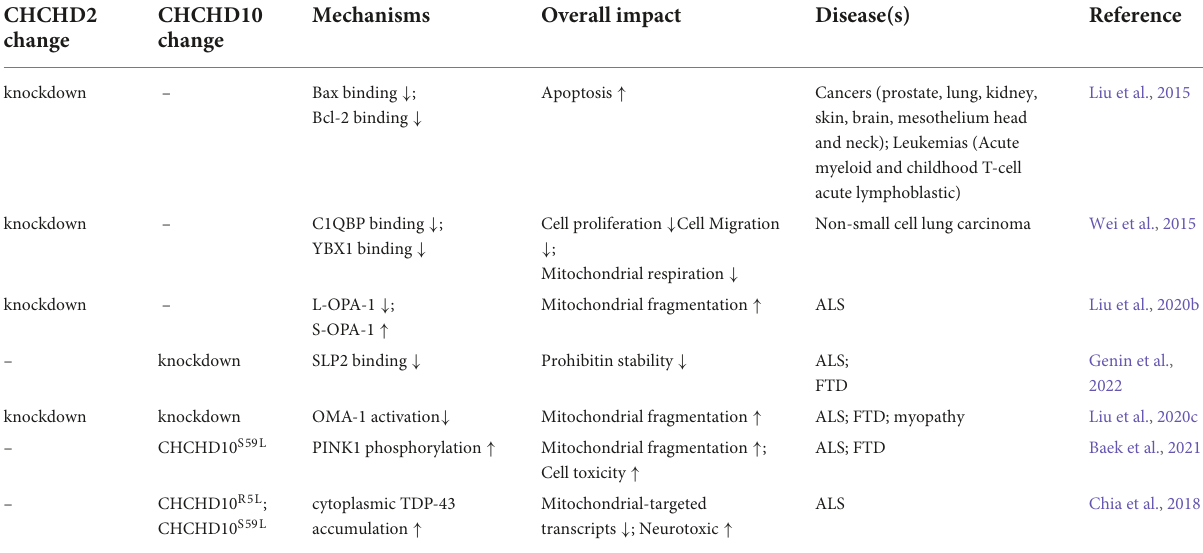
TABLE 1 Current findings in CHCHD2 and CHCHD10 involved mechanisms in